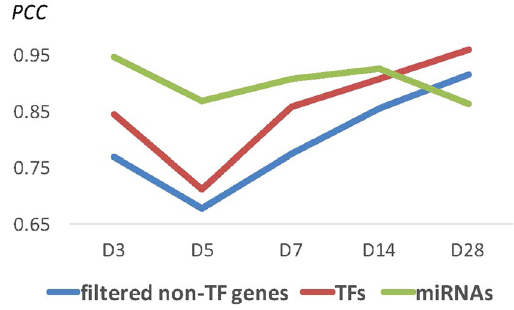
Figure 1. Pearson correlation coefficients ( PCCs ) of the expression intensity values of filtered non-TF genes (with expressional differences greater than 1 standard deviation but excluding those at the top and bottom 1% intensity values), TF genes, and microRNAs between with and without pressure overload in the cardiac samples at days 3, 5, 7, 14, and 28. The blue, red, and green lines represent the PCC s for filtered non-TF genes, TF genes, and microRNAs,